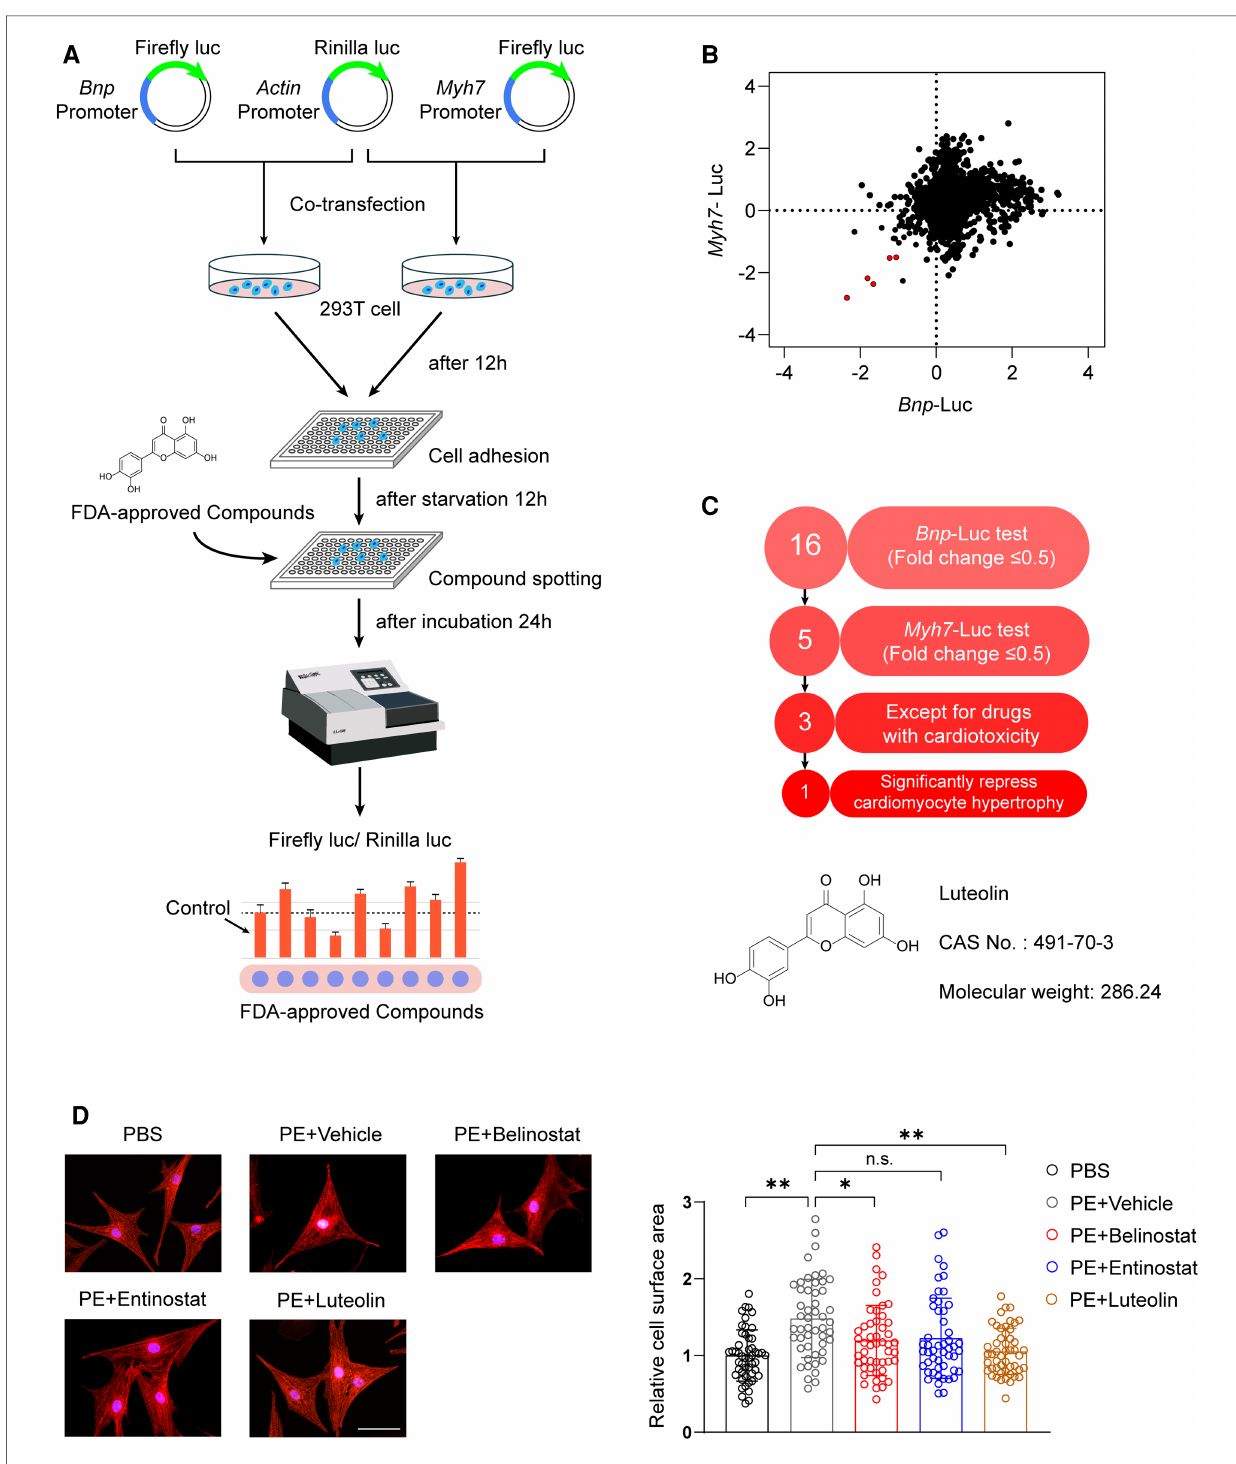
FIGURE 1 Luteolin emerged as a therapeutic candidate for pathological cardiac hypertrophy in the FDA-approved chemical compounds screen. ( A ) Schematic illustration of the experimental work fl ow of the luciferase-based FDA-approved chemical compounds screen. ( B ) The scatter plot demonstrating Myh7 and Bnp luciferase activity in HEK 293 T cells treated with FDA-approved compounds. Red dots represent each FDA drug that inhibited both Myh7 and Bnp luciferase reporter activities for more than 50%. ( C ) The advancement criterion for screening out the most effective compound on Myh7 and Bnp luciferase activity downregulation and cardiomyocyte hypertrophy inhibition. ( D ) Representative immuno fl uorescence images (left) of α -actinin staining and quantitative results of the cell surface area (right) of NRCMs treated with PBS, PE (50 μ M), PE+entinostat, PE+belinostat, or PE +luteolin for 24 h ( n ≥ 50 cells per group). Scale bar, 50 μ m. The data shown are representative of three independent experiments. Values are presented as mean±SD. * P <0.05, ** P <0.01, n.s., no signi fi cant difference. FDA, the United States Food and Drug Administration; NRCMs, Primary neonatal rat cardiomyocytes; HEK 293 T cells, human embryonic kidney 293 T cells; luc, luciferase; Bnp , b-type natriuretic peptide; Myh7, myosin heavy chain 7; PE,